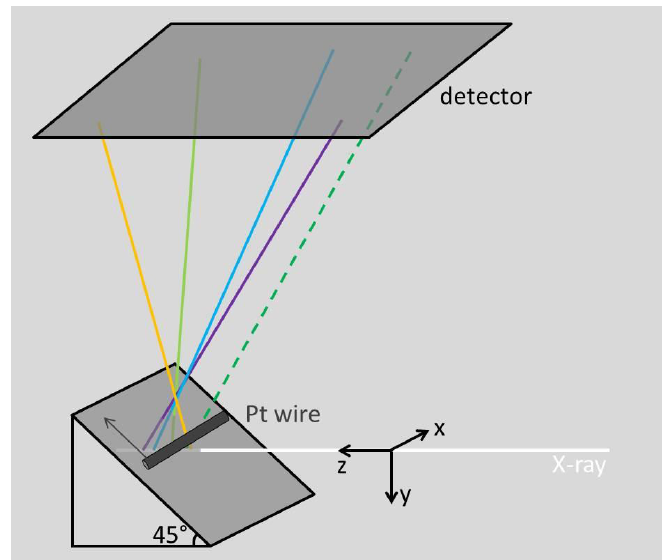
Figure 1. A sketch showing the experimental set-up of the differential aperture X-ray microscopy (DAXM). The Pt wire is used as a differential aperture to resolve where different diffracted signal (represented as colored lines) recorded by the 2D panel detector is originating from within the sample volume illuminated by the focused microbeam.